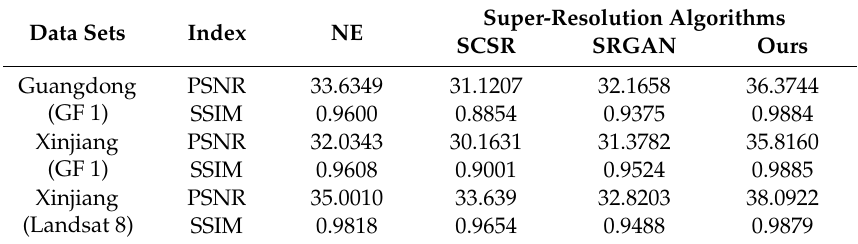
Figure 7. Comparison of the output of our ISRGAN model (the fifth column) to other models (NE, SCSR, SRGAN). Figures ( a ) and ( b ) are the results of the GF 1 dataset in Guangdong, ( c ) is the result of the cross-location testing in the GF 1 dataset in Xinjiang, and ( d ) is the result of Landsat 8 in Xinjiang. The ground truth is shown as HR. The low-resolution inputs are marked as LR. Table 7. Image quality comparison of di ff erent super-resolution